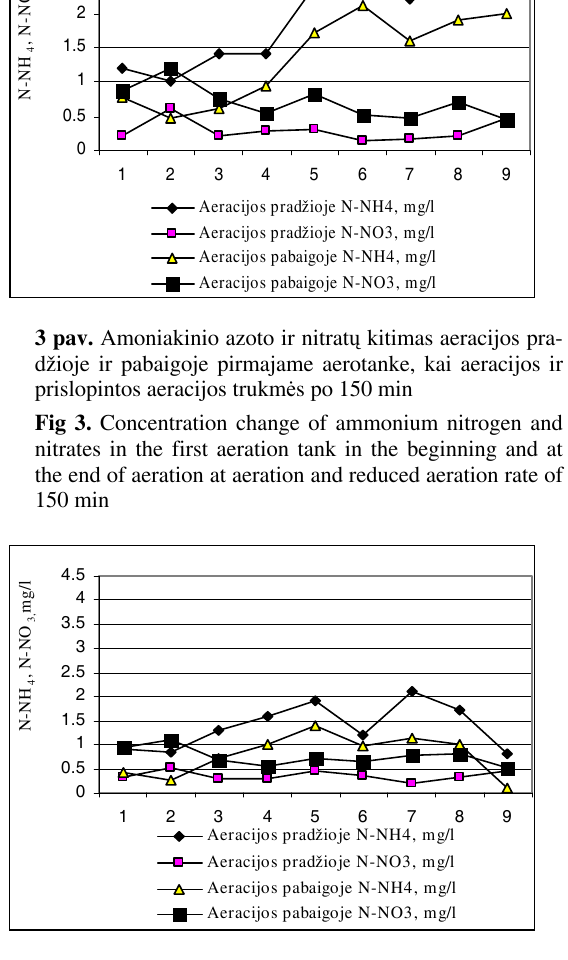
Fig 4. Concentration change of ammonium nitrogen and nitrates in the second aeration tank in the beginning and at the end of aeration at aeration and reduced aeration rate of 150 min Taigi pirmojo eksperimento rezultatai padiktavo s ą -